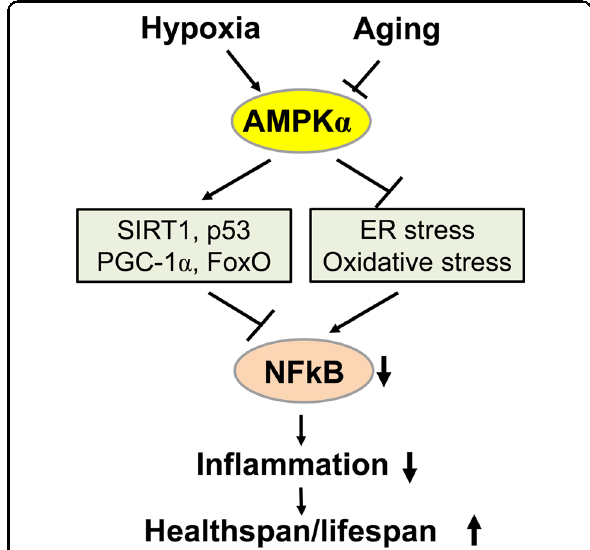
Fig. 6 The AMPK pathway links hypoxia and aging to NF κ B signaling and in fl ammation. Hypoxia activates AMPK. In contrast, aging appears to inhibit the expression and activity of AMPK α .